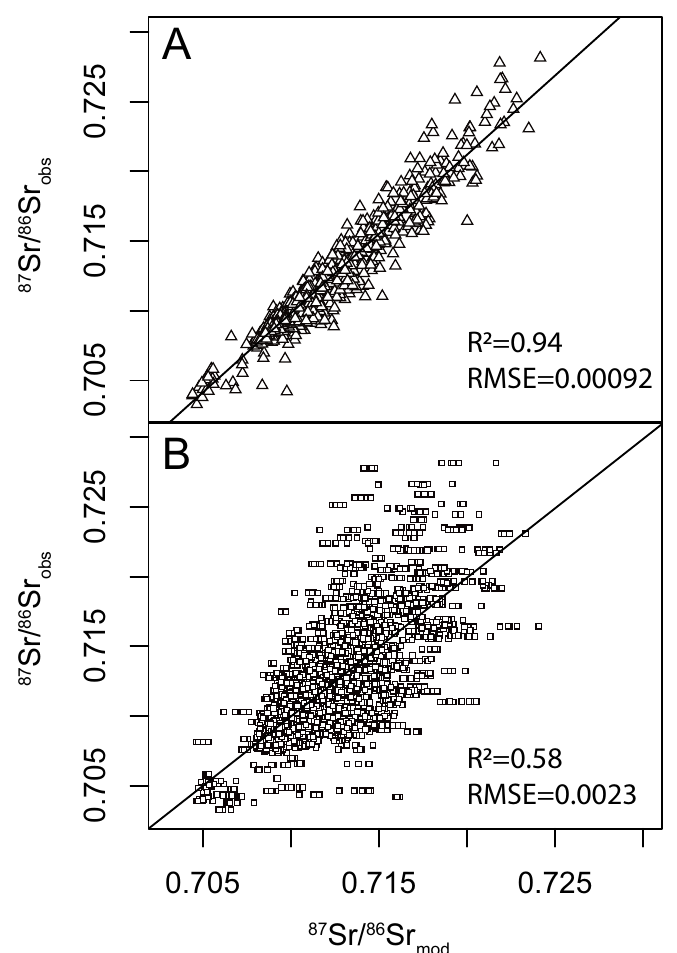
Fig 5. Scatter plots of observed vs. predicted 87 Sr/ 86 Sr ratios. A. Training dataset, B. 10-fold cross-validation testing dataset. R 2 = coefficient of determination; RMSE = root mean square error.